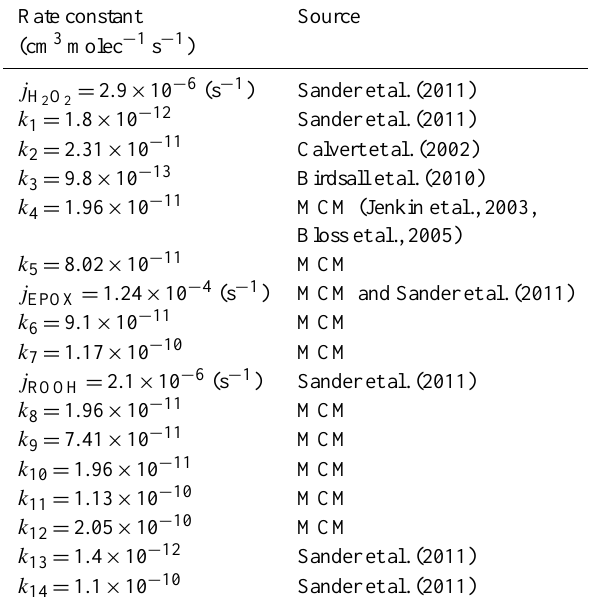
Table 3. Rate constants for the photochemical